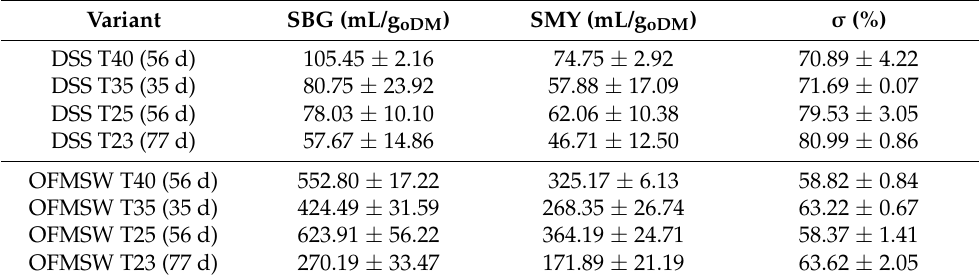
Table 4. Specific biogas yields (SBG), methane yields (SMY), and CH 4 concentrations ( σ ) of the digested sewage sludge (DSS) and the organic fraction of municipal solid waste (OFMSW) at different temperatures and retention times; mean values ± standard deviation. Variant SBG (mL/g oDM ) SMY (mL/g oDM